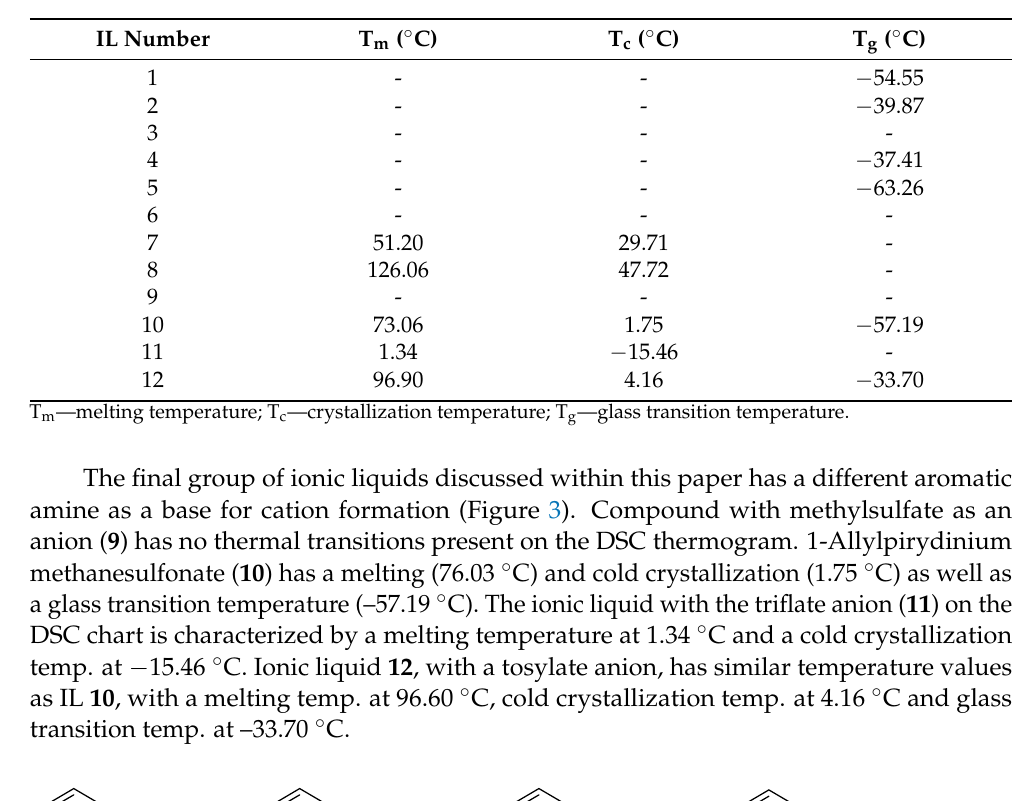
Table 1. Thermal transitions obtained with DSC measurements for 12 ionic liquids.